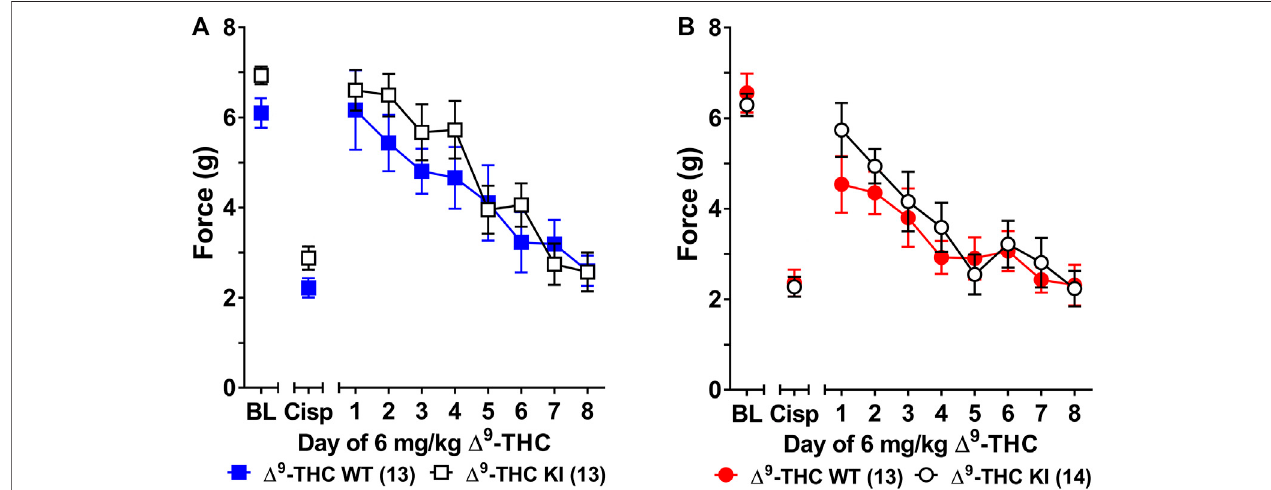
FIGURE 1 | Development of tolerance to the anti-allodynic effects of 6 mg/kg of Δ 9 -THC in male and female wild-type and S426A/S430A mice. Tolerance to the anti-allodyniceffectsof6 mg/kg Δ 9 -THCwasdeterminedinbothmale (A) andfemale (B) S426A/S430A(KI;un fi lled)andwild-type(WT; fi lled)mice.Micewereassessed viathevonFreyassayfortheamountofforce(ingrams)requiredtoelicitapawwithdrawalresponse60 minfollowingtreatmentwith6 mg/kg Δ 9 -THC.BLrepresentsthe pre-cisplatinbaselineandCISPthepost-cisplatinbaseline.Errorbarsrepresentthemean ± SEM.Eachmousewastestedintriplicateandthosevaluesaveragedto determineasinglevalueforeachmouseeachdayoftesting.Datawereanalyzedusingseparatetwo-wayANOVAswithBonferronipost-hoctests.Samplesizesforeach group (shown in parentheses) include 26 male (13 WT; 13 KI) and 27 female (13 WT; 14 KI)